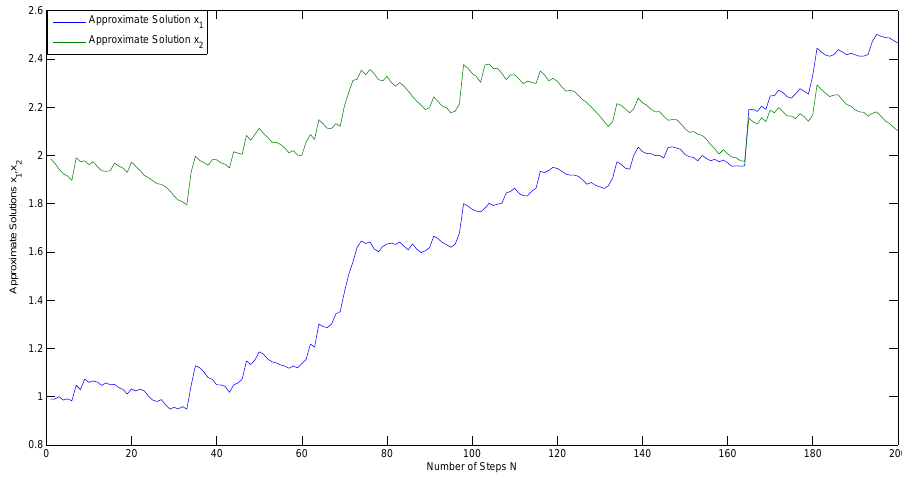
Figure 1: Approximate solutions of